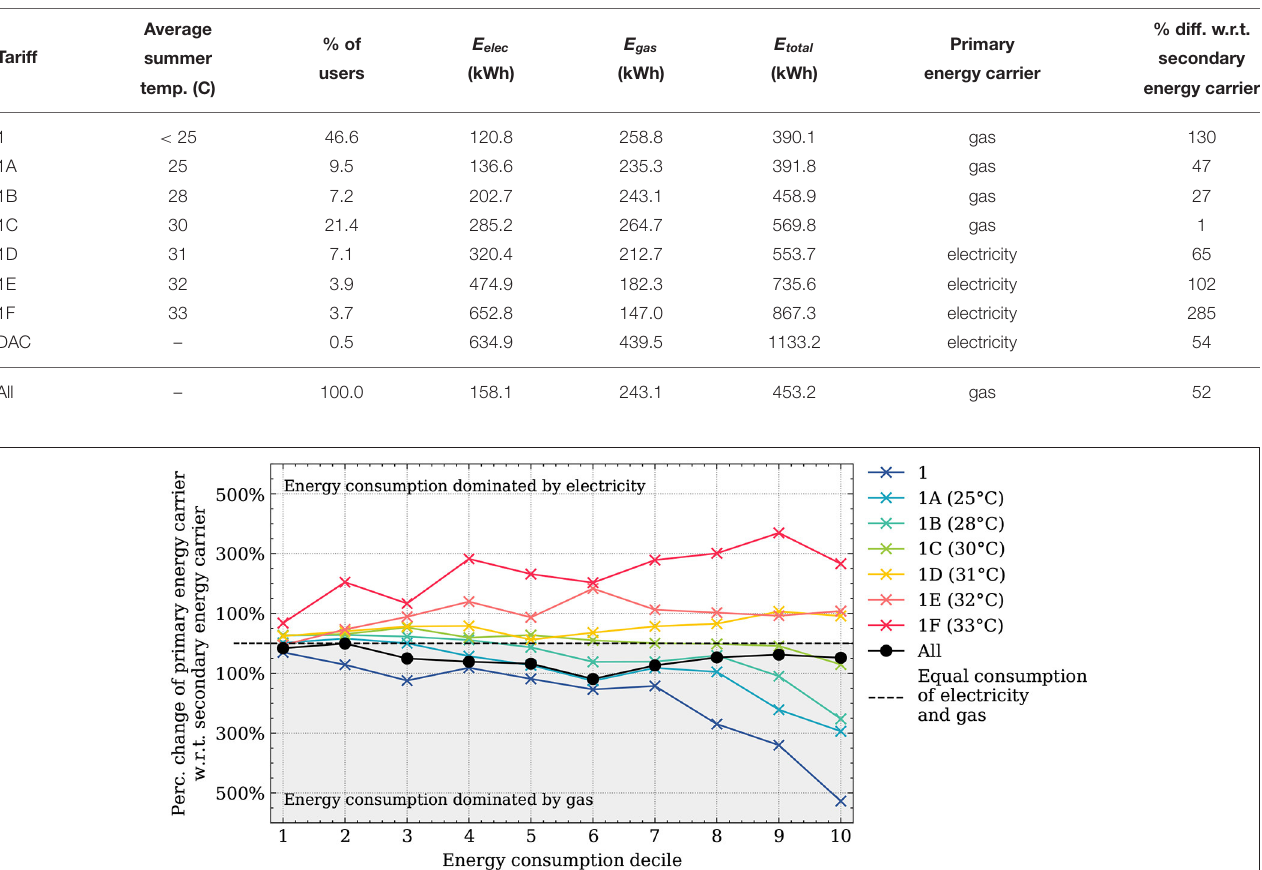
TABLE 4 | Distribution of ENIGH 2018 households per tariff class and calculated median monthly energy consumption by energy carrier; primary energy carrier, i.e., energy carrier that dominates the total energy consumption, and its percentage difference with respect to the secondary energy carrier.